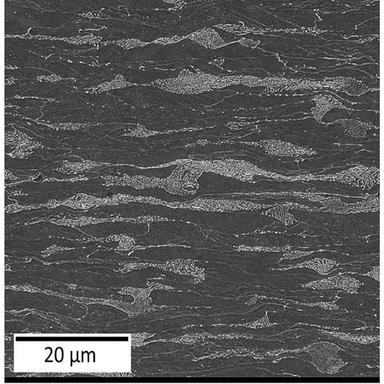
Initial ferritic-pearlitic microstructure of the steel after 50% cold reduction, being ferrite in grey and pearlitic colonies in white.